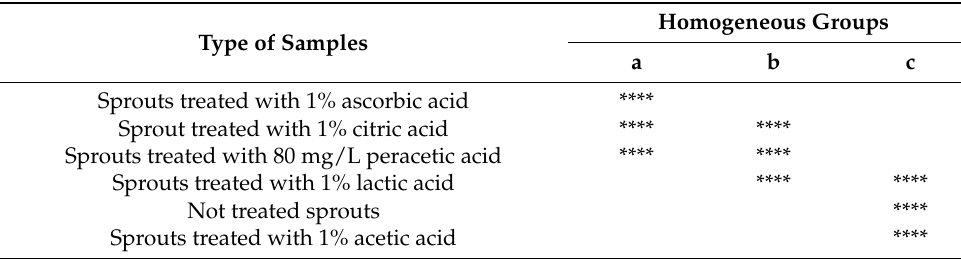
Table 8. Group homogeneity test ( α = 0.05) comparing the effect of the organic acids used on the ∆ E* values of red cabbage sprouts subjected to 7-day storage.